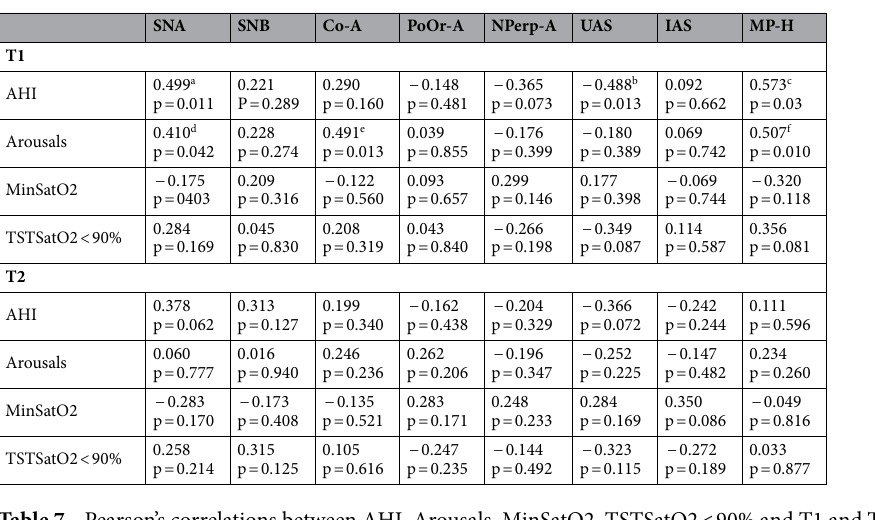
(Table 8). The significant correlations were as follows: preoperative AHI was significantly correlated with preoper- ative CoA (r = 0.424/p = 0.044), PoOr-A (r = 0.551/p = 0.006), and MPH (r = 0.479/p = 0.021); preoperative arous- als were significantly correlated with preoperative UAS (r = − 0.440/p = 0.035); and minimum preoperative O2 saturation was significantly correlated with preoperative SNA (r = − 0.415/p = 0.049), SNB (r = − 0.468/p = 0.024), and CoA (r = − 0.414/p = 0.049). (Online Supplementary Figures 8–14). The mediation regression was shown to be significant with p values < 0.05 between the association SNB/